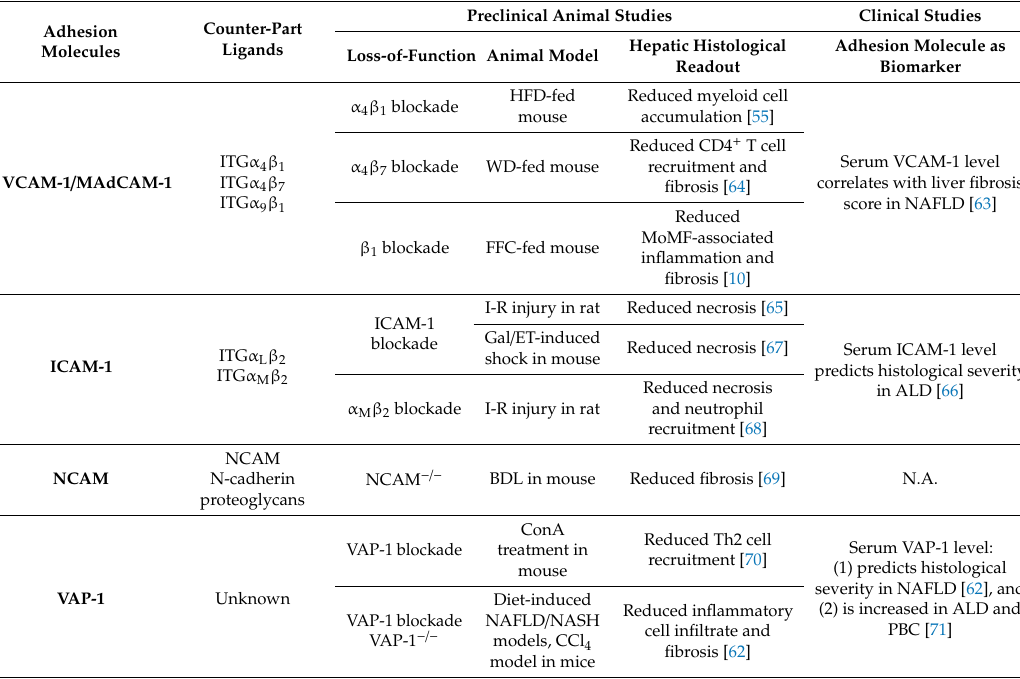
Table 1. Functional roles and clinical relevance of LSEC adhesion molecules and their counterpart ligands in liver